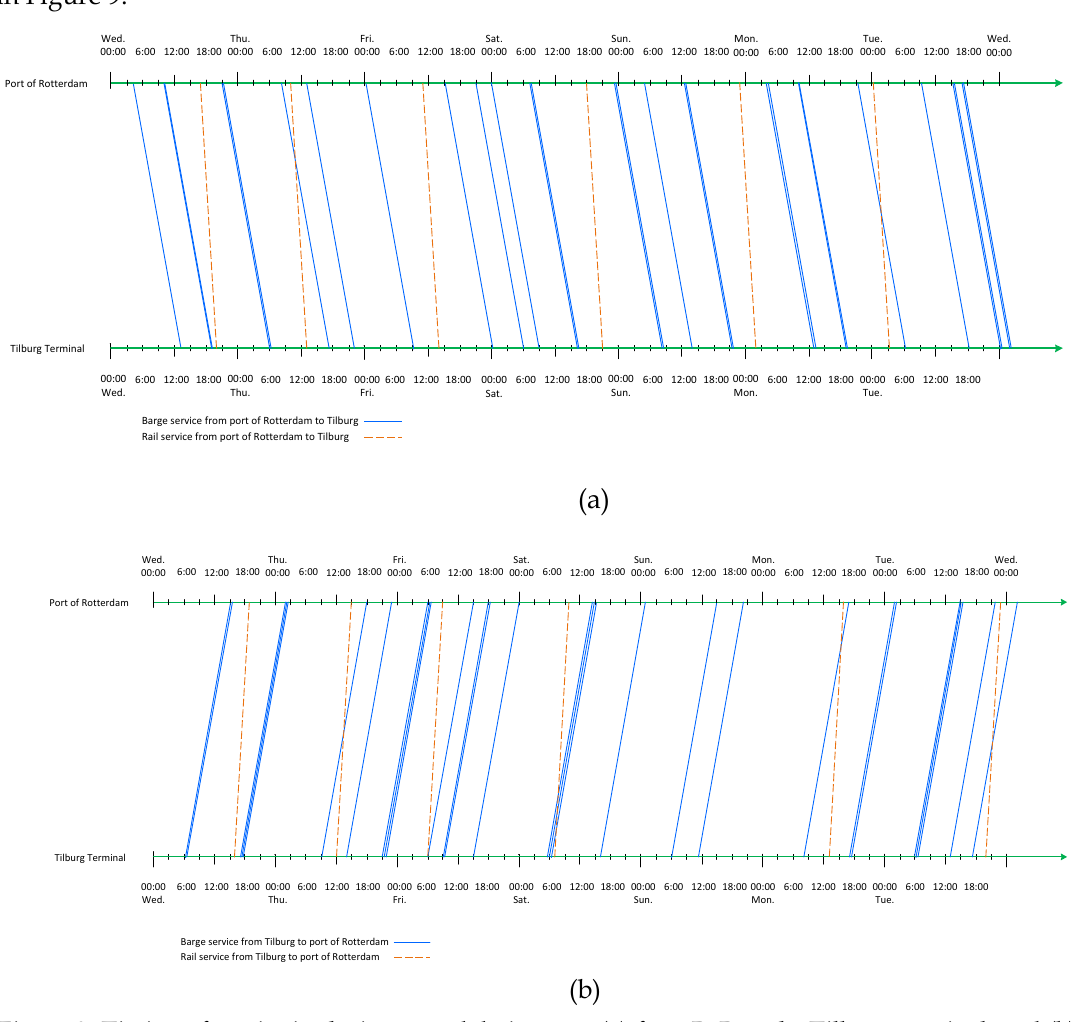
Figure 9. Timing of service in the integrated design case (a) from PoR to the Tilburg terminal, and (b) and from the Tilburg terminal to